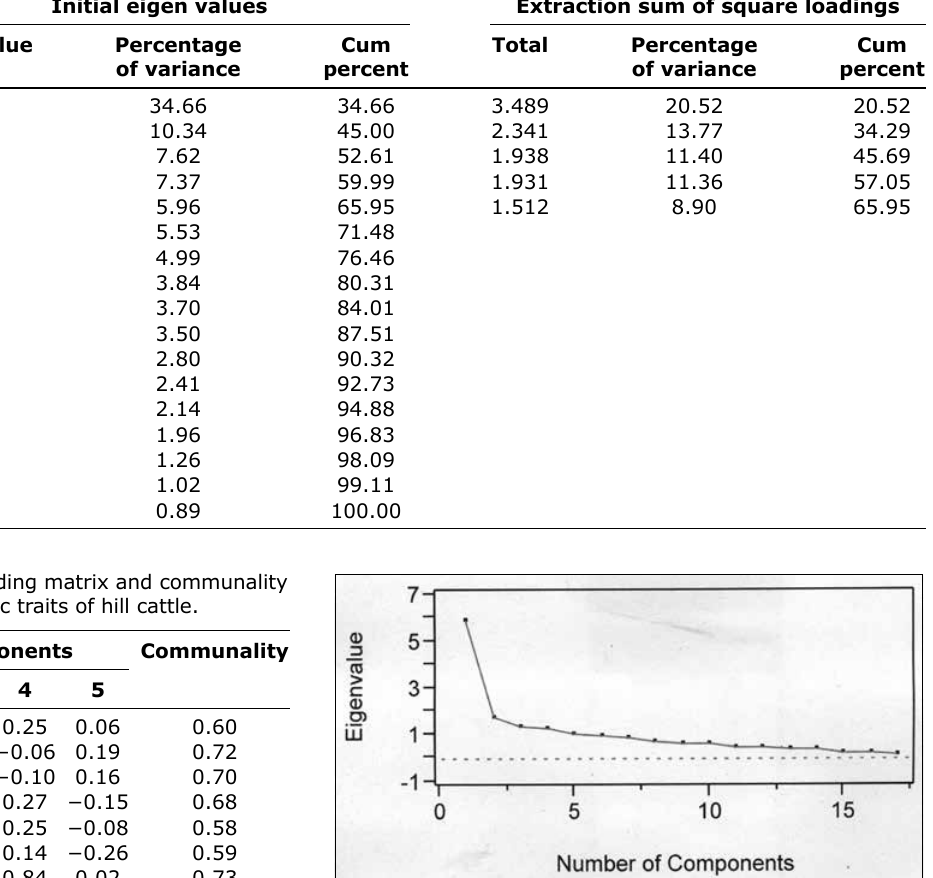
Table-2: Total variance explained by different component in adult hill cattle of Himachal Pradesh. Component